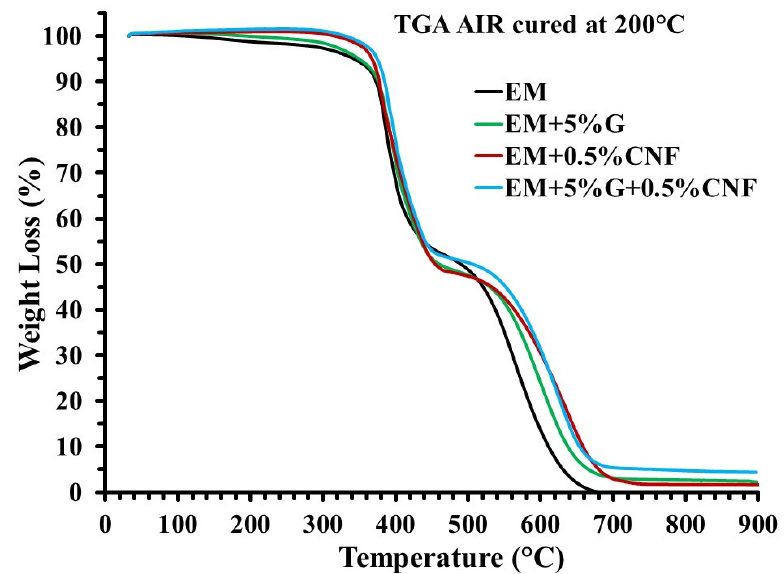
Figure 3. TGA curves in air of the epoxy samples isothermally solidified.